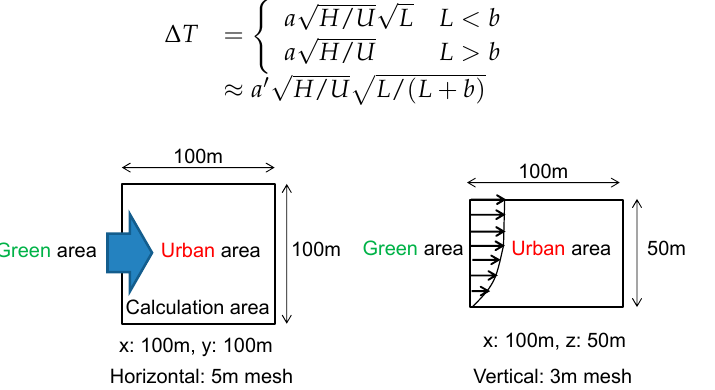
Figure 10. Outline of modified calculation conditions.